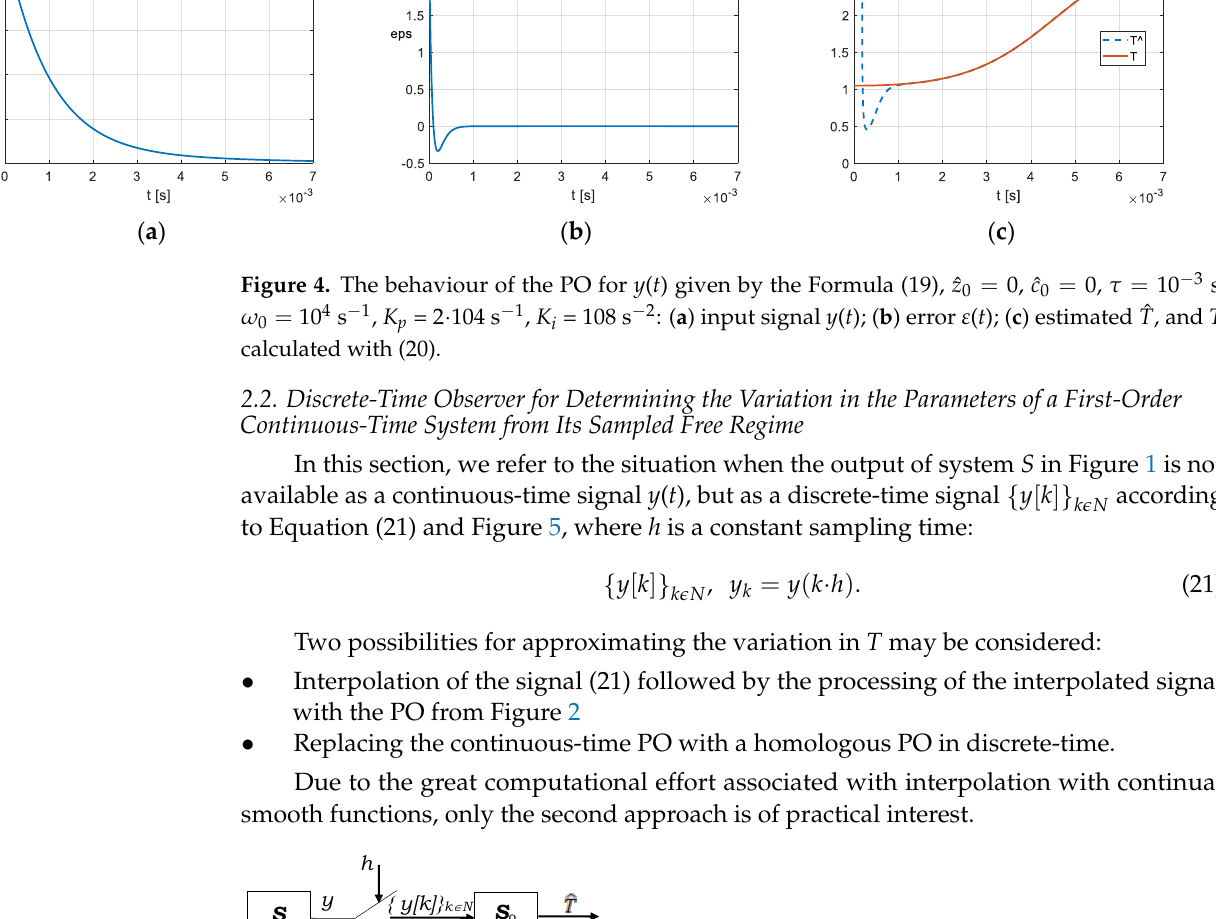
Figure 5. The block diagram of the observation of the parameter T .